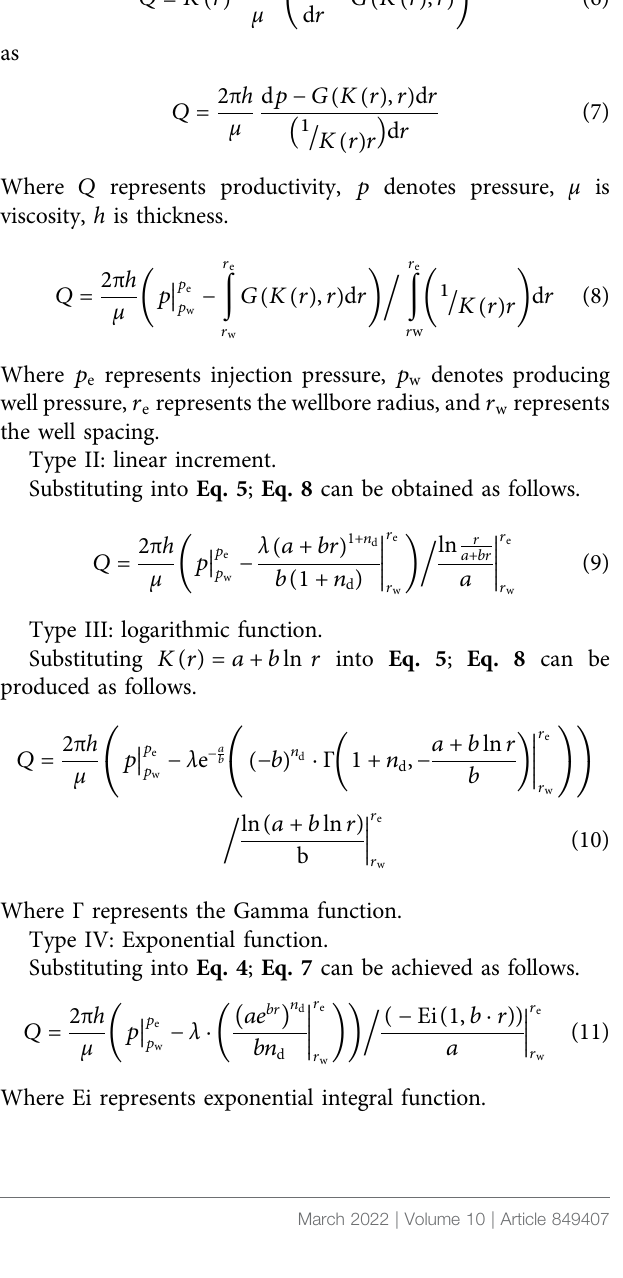
Frontiers in Earth Science |